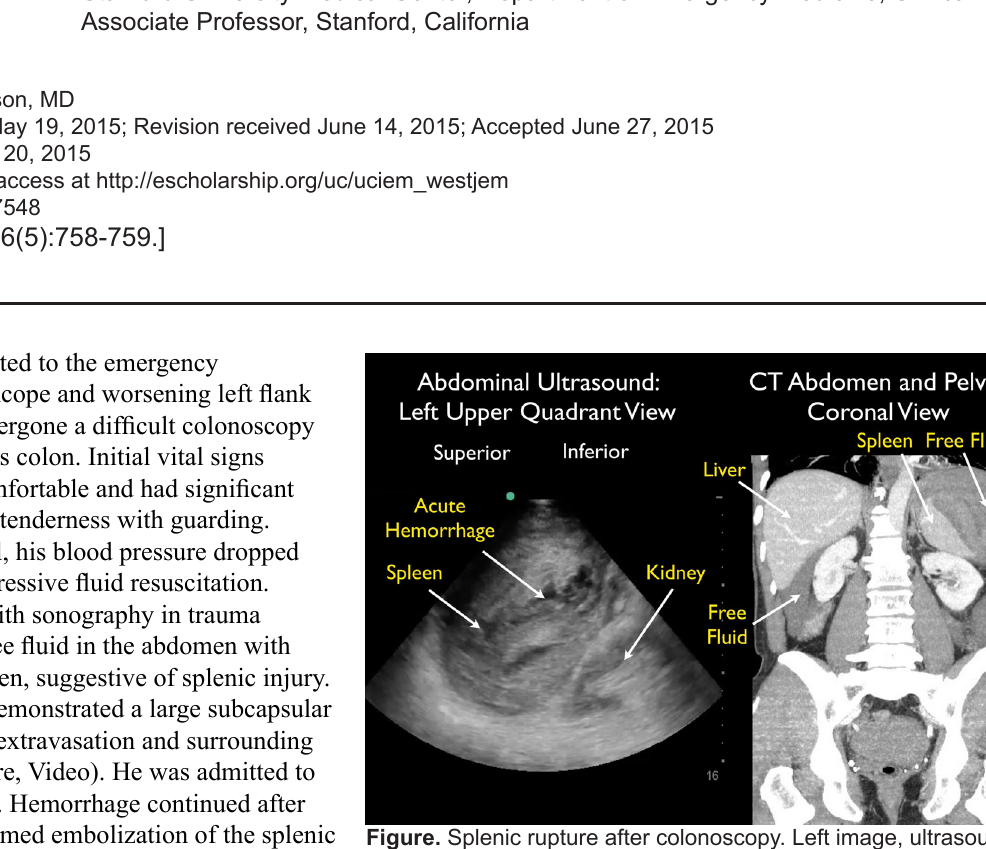
Right image, computed tomography scan